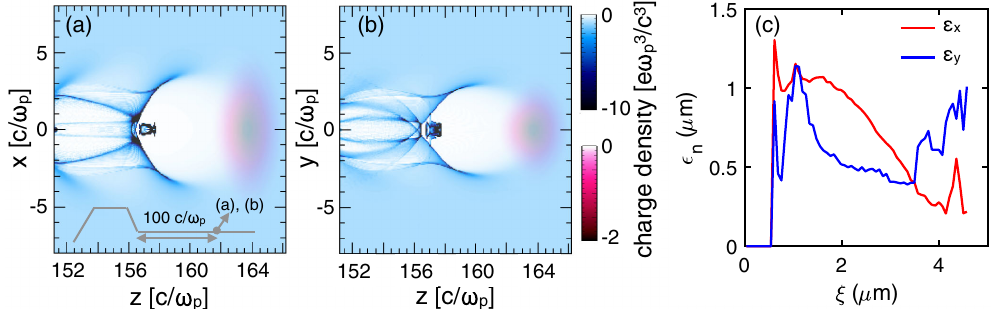
FIG. 7. Noncylindrical driver case. (a) and (b) are plasma densities in the transverse planes taken after the beam has been accelerated for ∼ 100 c= ω p , as indicated by the inset in (a). (c) The normalized slice emittance in the transverse